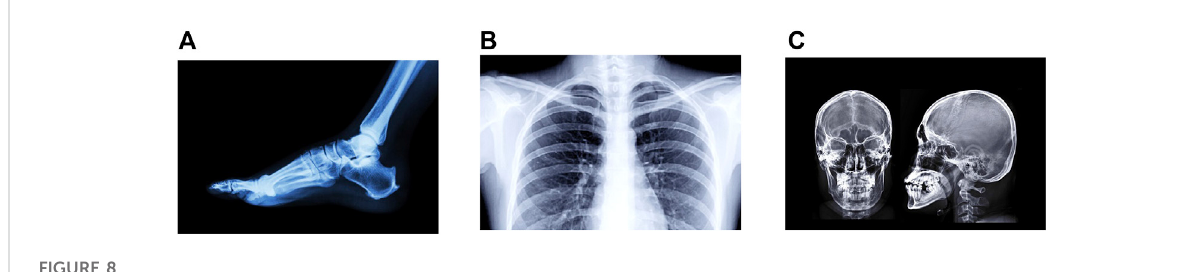
FIGURE 8 Figures A – C represents the secret images used in the experiments carried out.